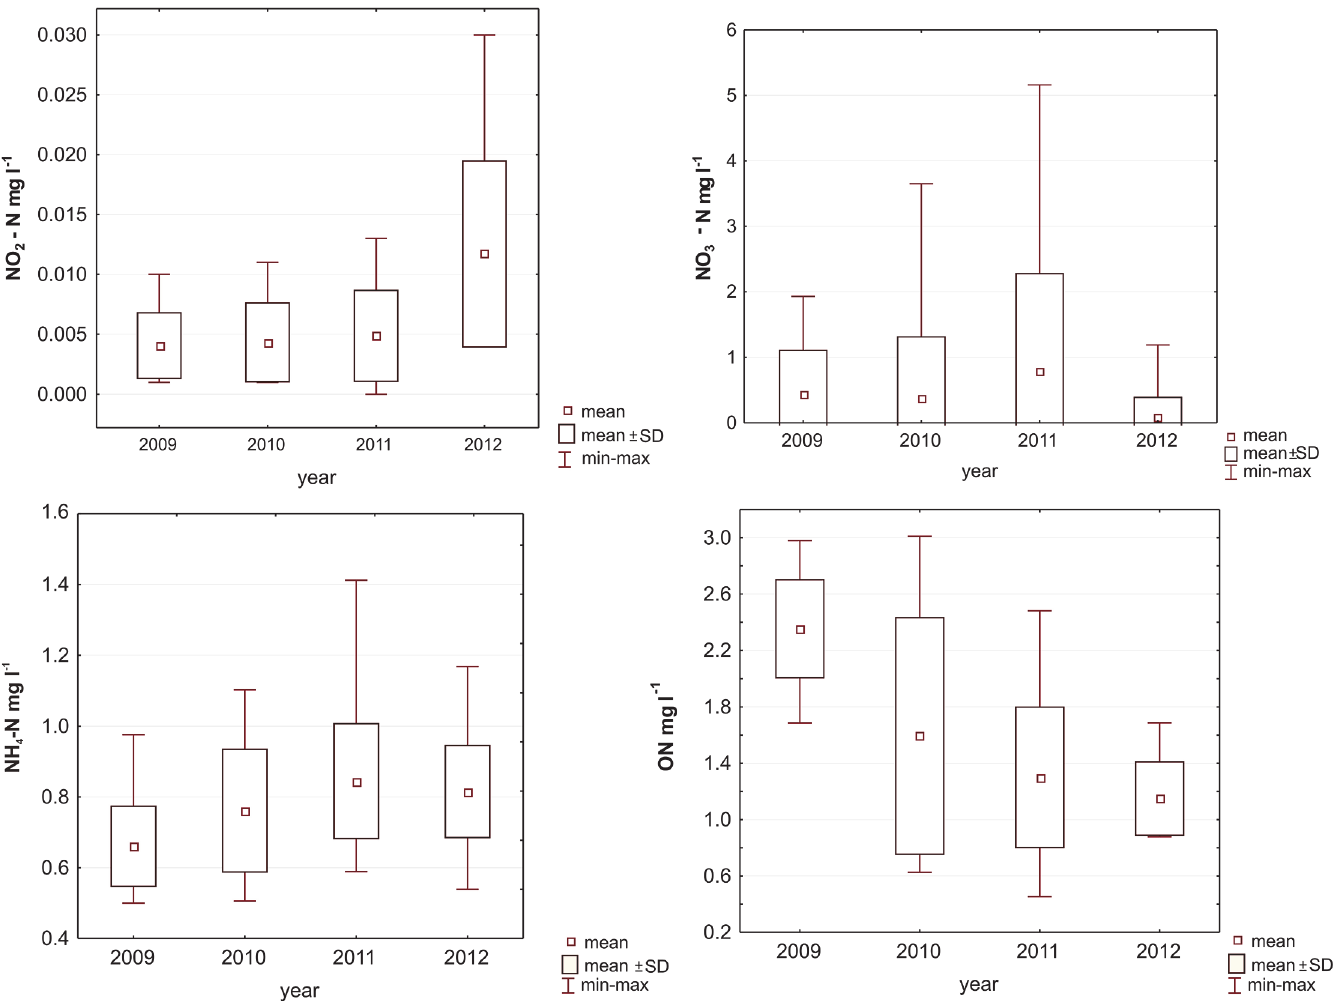
Fig 1. Concentration of nitrogen forms in Malta ń ski